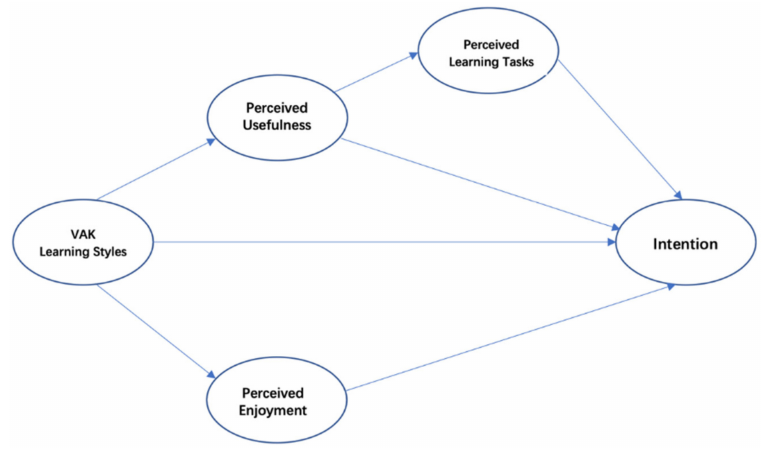
Figure 3. Technology-Learning Behavior Acceptance Model